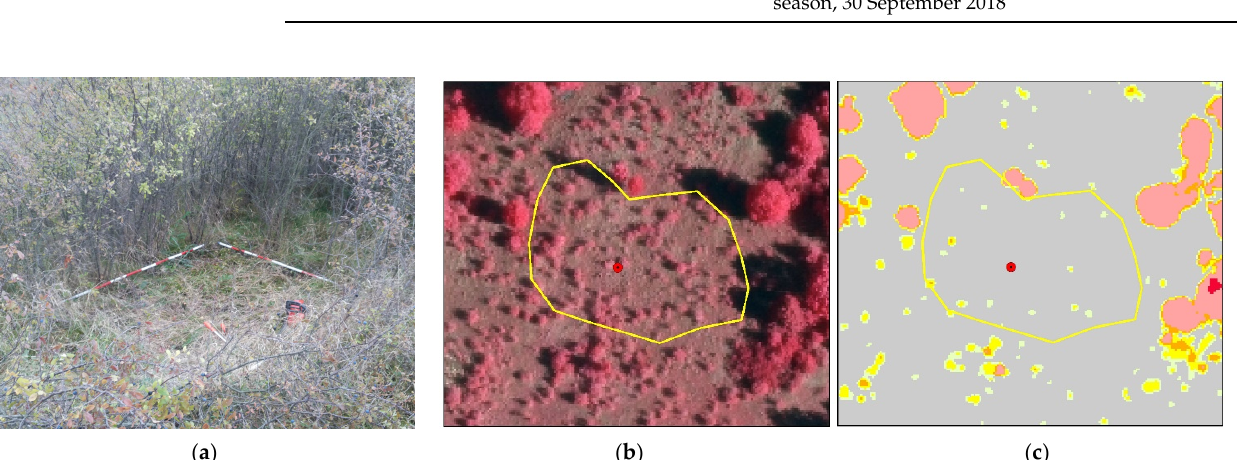
Figure 3. ( a ) Field survey: cut out of biomass from a sub-area of 2 × 2 m; ( b ) the identification of homogeneous land cover areas around the field survey plots based on aerial CIR images; ( c ) nDSM layer derived for airborne Lidar survey.